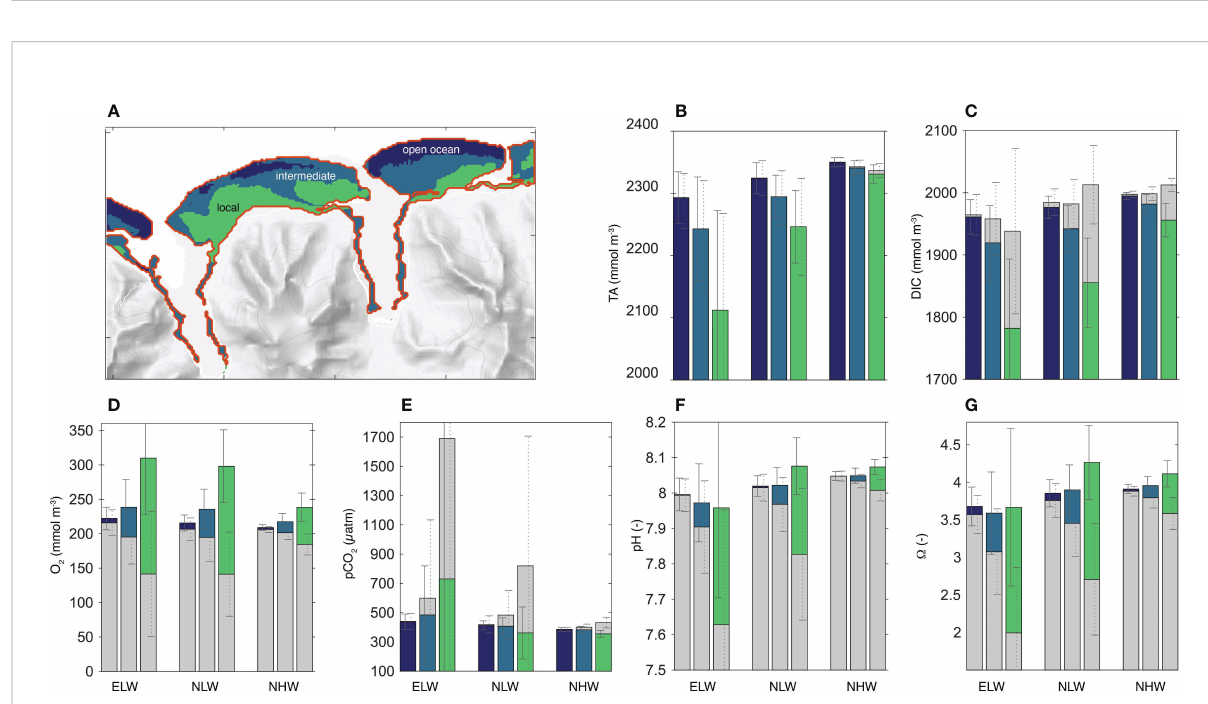
FIGURE 9 Emergence of biogeochemical niches: (A) Map showing the three biogeochemical niche clusters considered in our study. Average TA (B) , DIC (C) , dissolved oxygen (D) , p CO 2 (E) , pH (F) and the saturation state Ω a (G) for each cluster (color) and each wave regime. Also shown is the diurnal range with the average day and average nighttime concentrations, with the colored column indicating the daytime concentrations, and the grey column indicating the nighttime concentrations. Since the two columns are plotted on top of each other with the taller bar in the back and the smaller one in the foreground, the diel range is given by the upper section of the column. If this section is colored (e.g., for O 2 , pH, and Ω a ), then the daytime concentrations exceeds the nighttime ones. If the top section is grey (e.g., for DIC and concentrations exceed those during the day. The diel range of TA is too small to be clearly